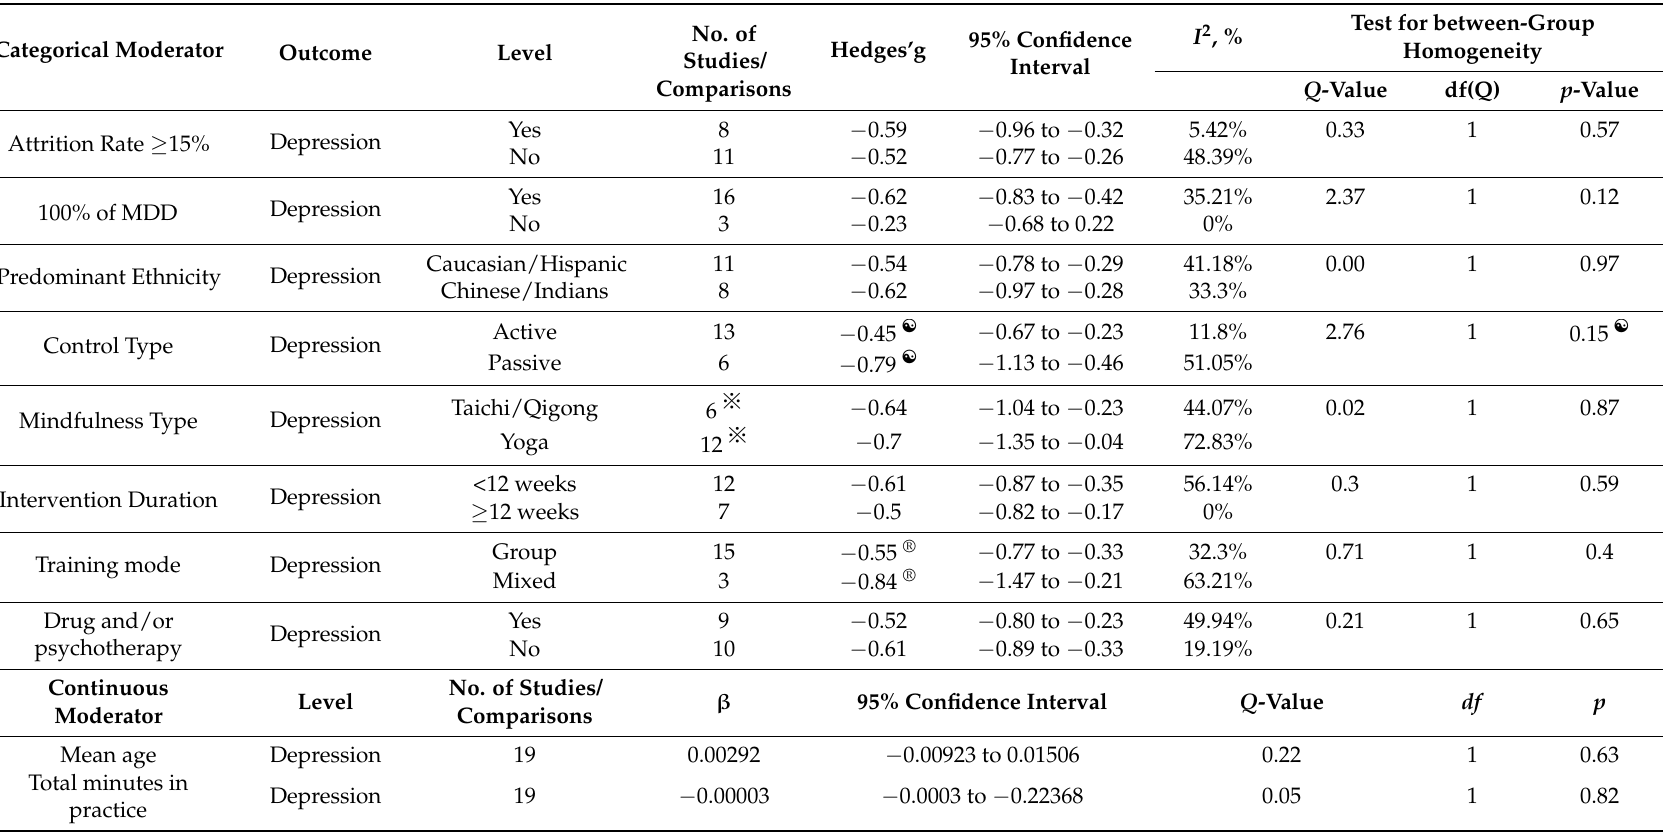
Table 1. Characteristics of all randomized controlled trials. Table 3. Moderator analysis for depression severity.